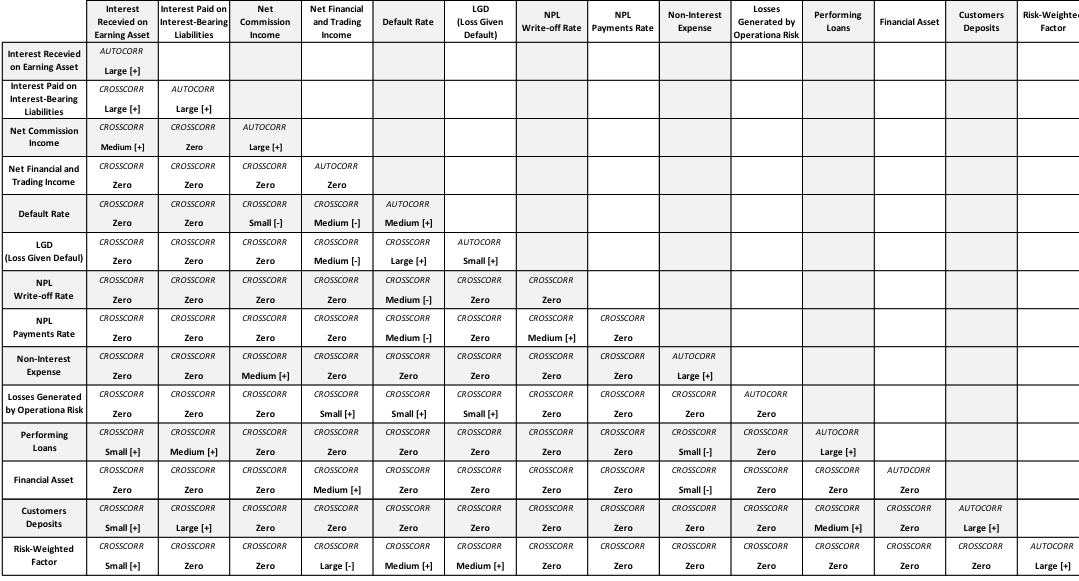
Figure A3. Correlations assumptions.